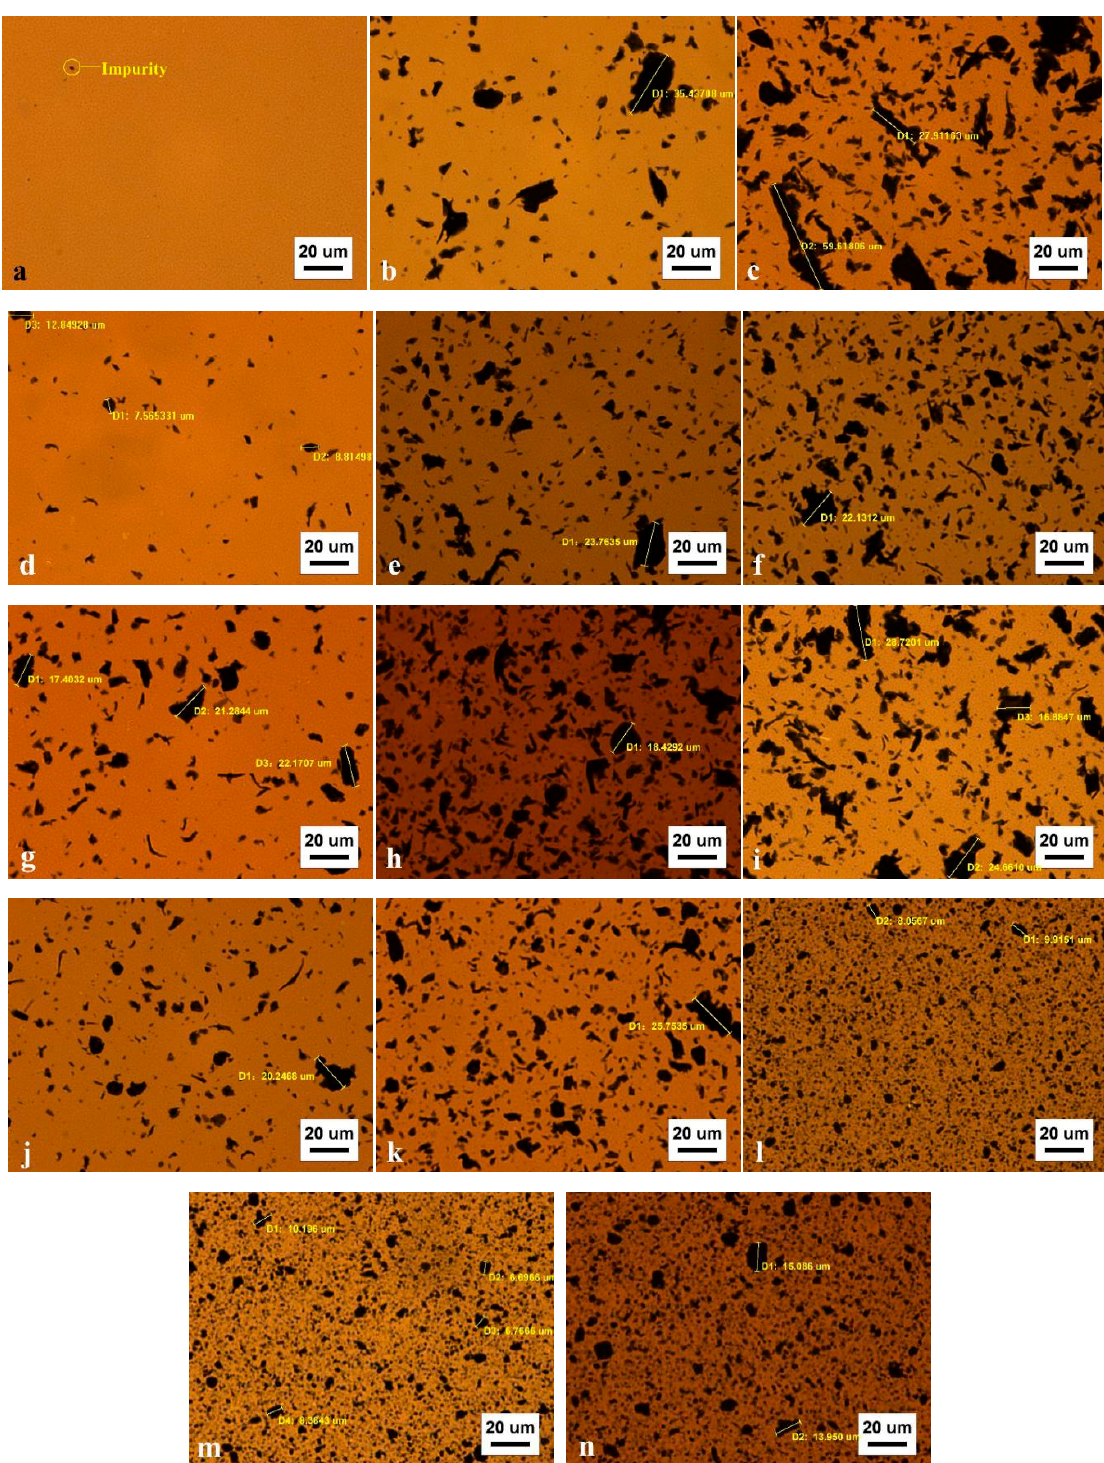
Figure 6. Microscopy test results ( a is the test result of SK-70# matrix asphalt; b – k are the test results of GMA uniform design groups 1–10; l – n are the test results of B-1~B-3 GMA).